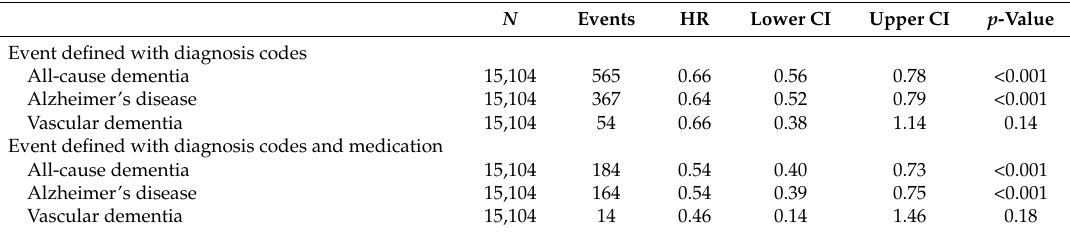
CI, 95% confidence interval; DPP-4i, dipeptidyl-peptidase IV inhibitor; HR, hazard ratio; N , number of patients; SU, sulfonylurea. Subgroup analyses were performed to determine whether age, sex, and DM complications influenced the protective effect of DPP-4i against dementia (Table 3). DPP-4i use was significantly associated with a lower risk of dementia in males and females. DPP-4i use was associated with a lower risk of dementia in patients aged ≥ 75 years (HR 0.61; 95% CI 0.50–0.76; p < 0.001) but not in those aged <75 years (HR 0.77; 95% CI 0.58–1.03; p = 0.08), compared to SU use. Patients without diabetic microvascular complications had a significantly lower HR for dementia in the DPP-4i group compared to the SU group (HR 0.64; 95% CI 0.52–0.78; p < 0.001). Among patients with diabetic microvascular complications, DPP-4i use was not significantly associated with an improvement in dementia (HR 0.74; 95% CI 0.53–1.03; p = 0.07). However, compared with SU use, DPP-4i use was associated with a lower risk of dementia irrespective of diabetic macrovascular